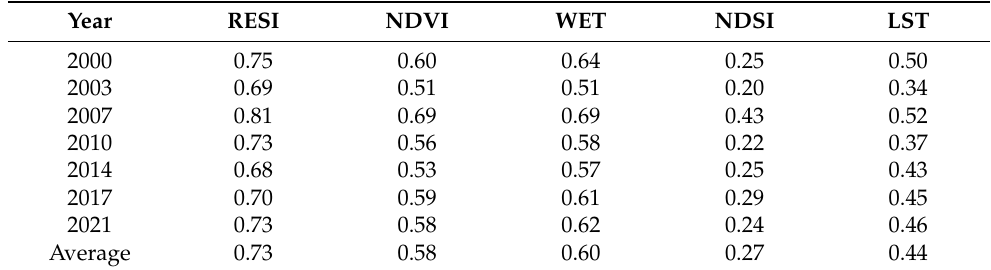
Figure 2. Correlation of each ecological factor with RSEI. Table 4. Average correlation of each